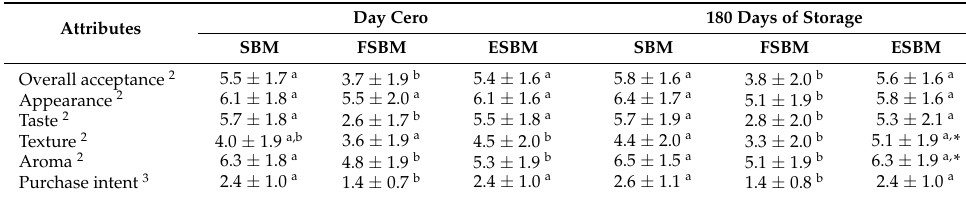
Table 5. Sensory acceptance and purchase intent of soybean meal (SBM), fermented soybean meal (FSBM) and enzymatically-processed soybean meal (ESBM) biscuits at day zero ( n = 101) and after 180 days of storage ( n = 80) 1